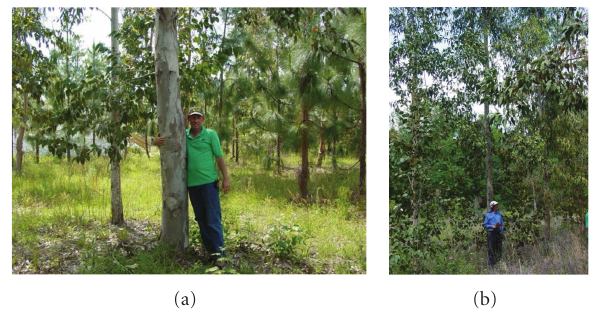
Figure 4: E. amplifolia seedling seed orchards at 8 years (a) and five years (b).